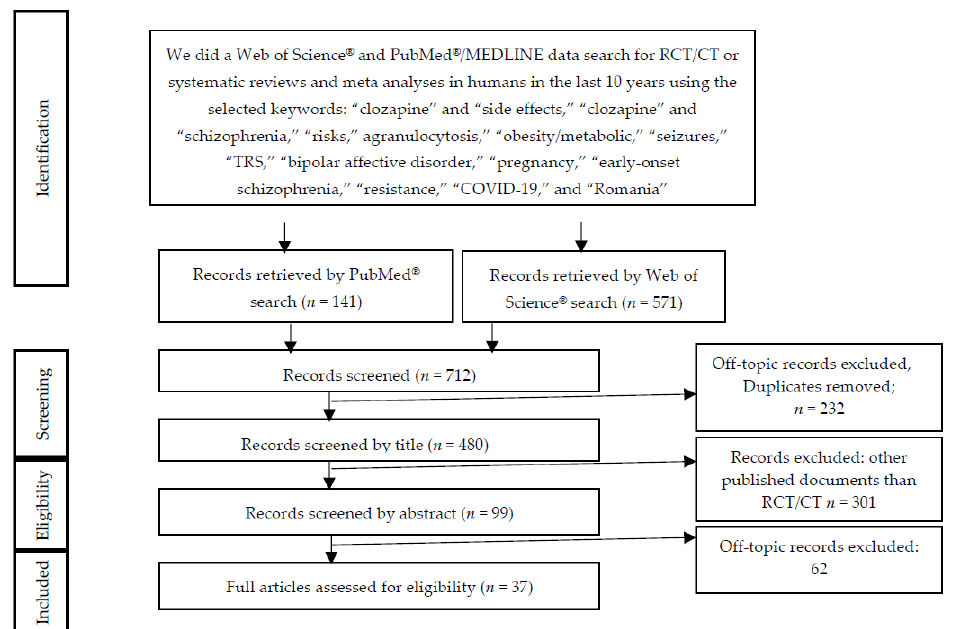
Figure 3. Preferred Reporting Items for Systematic Review and Meta-Analysis (PRISMA) diagram describing a systematic search and study selection process (RCT—Randomised Clinical Trials, CT—Clinical